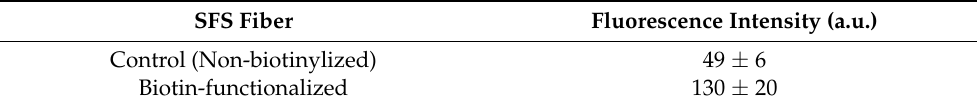
Table 2. Quantitative comparison of the fluorescence intensity of the control and biotinylated SFS fibers after being incubated with streptavidin-FITC. Two micrographs were taken from different regions of the fiber and, at least, three measurements of fluorescence intensity were obtained from each micrograph. Values are expressed as mean ± standard error.